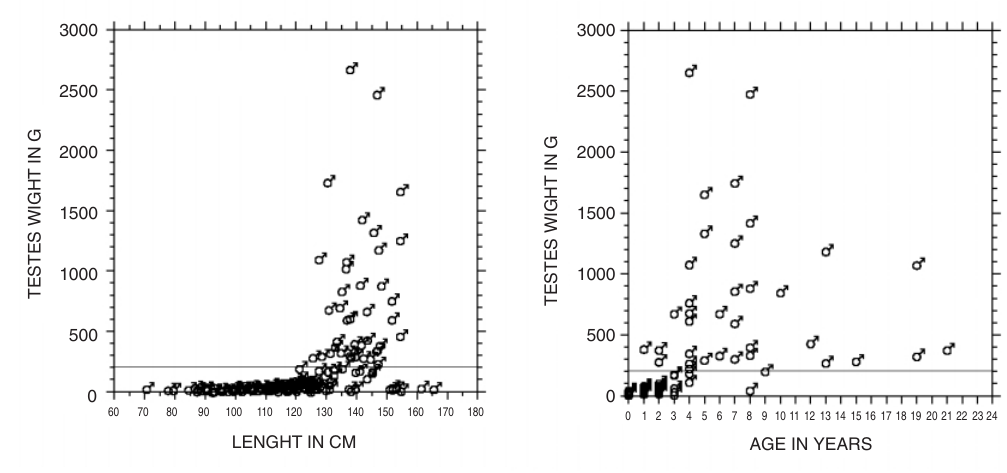
Fig. 7. Testes weight at body length in male porpoises